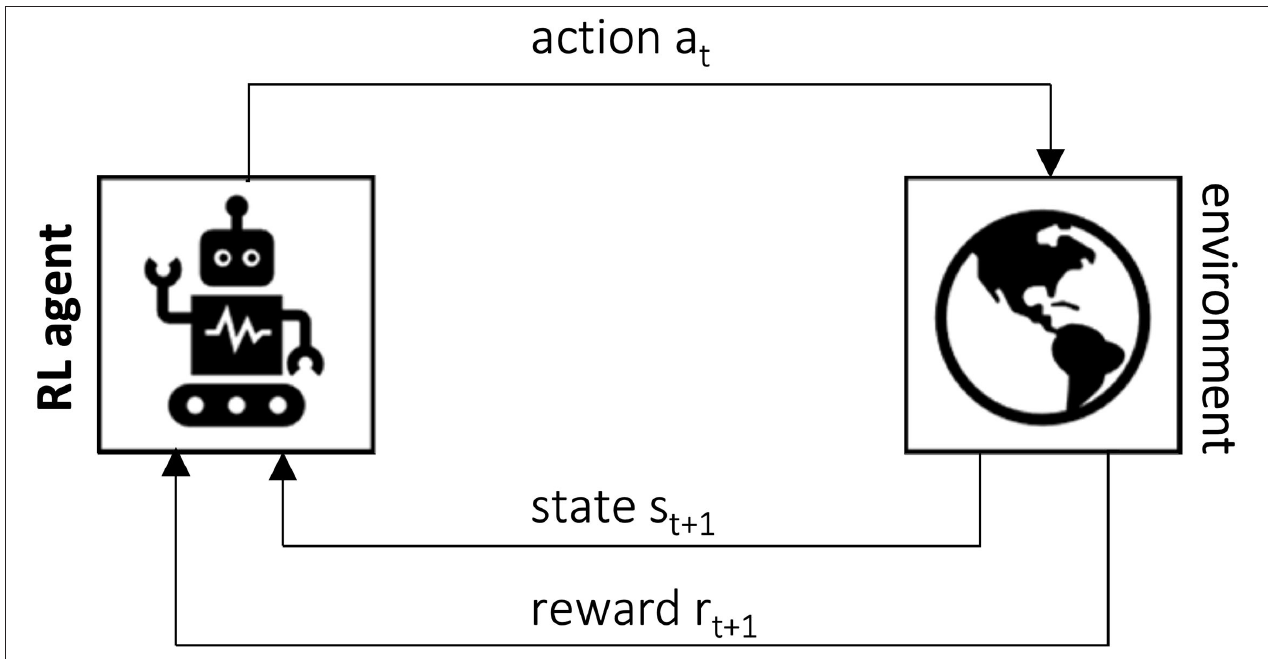
FIGURE 3 | The agent-environment interaction process in an RL setup (Sutton and Barto,